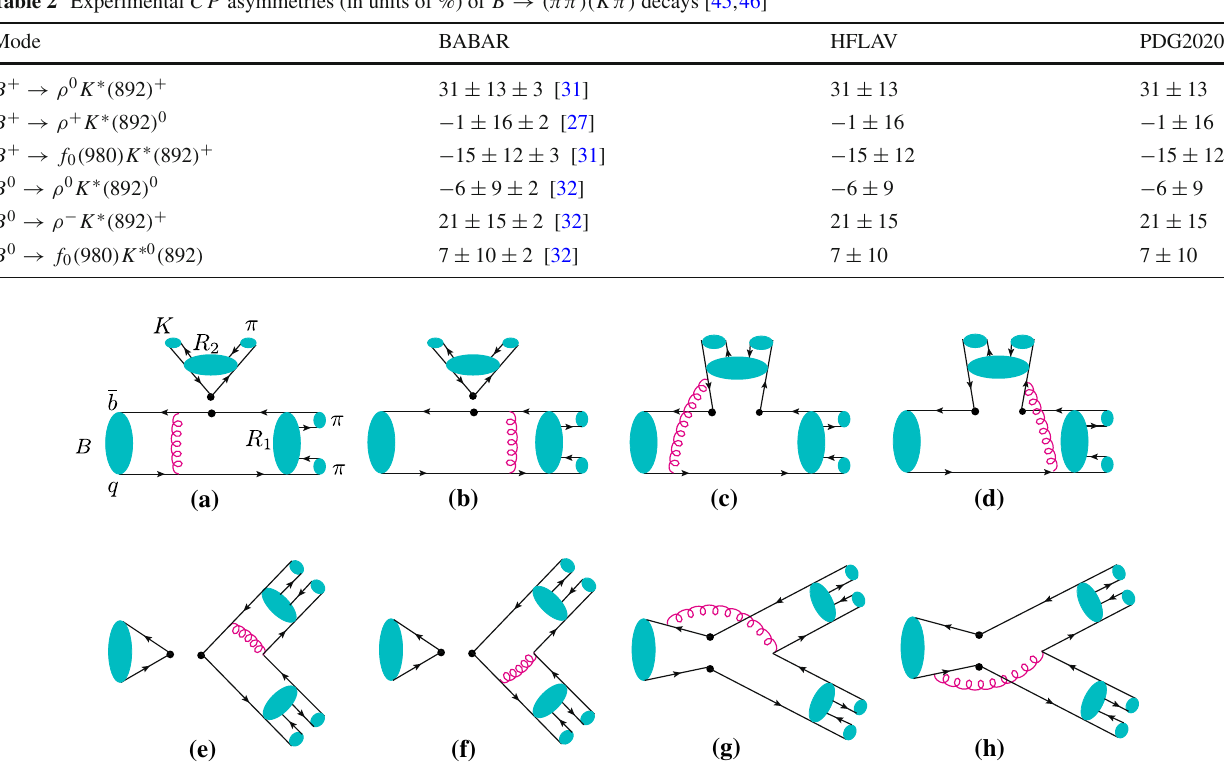
Fig. 2 Typical leading-order Feynman diagrams for the four-body decays B → ( R 1 → )ππ( R 2 → ) K π with q = ( u , d , s ) , where the symbol • denotes a weak interaction vertex. The diagrams ( a )–( d ) represent the B → ( R 1 → )ππ transition, as well as the diagrams